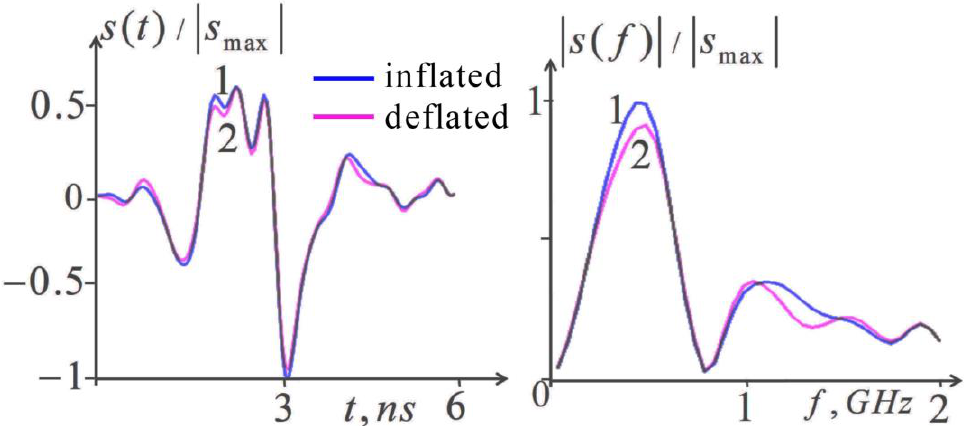
Figure 3. Numerical simulation of the lung inflation effect. Left, calculated received pulses; right, corresponding frequency spectra; 1, inflated lungs; 2, deflated lungs.